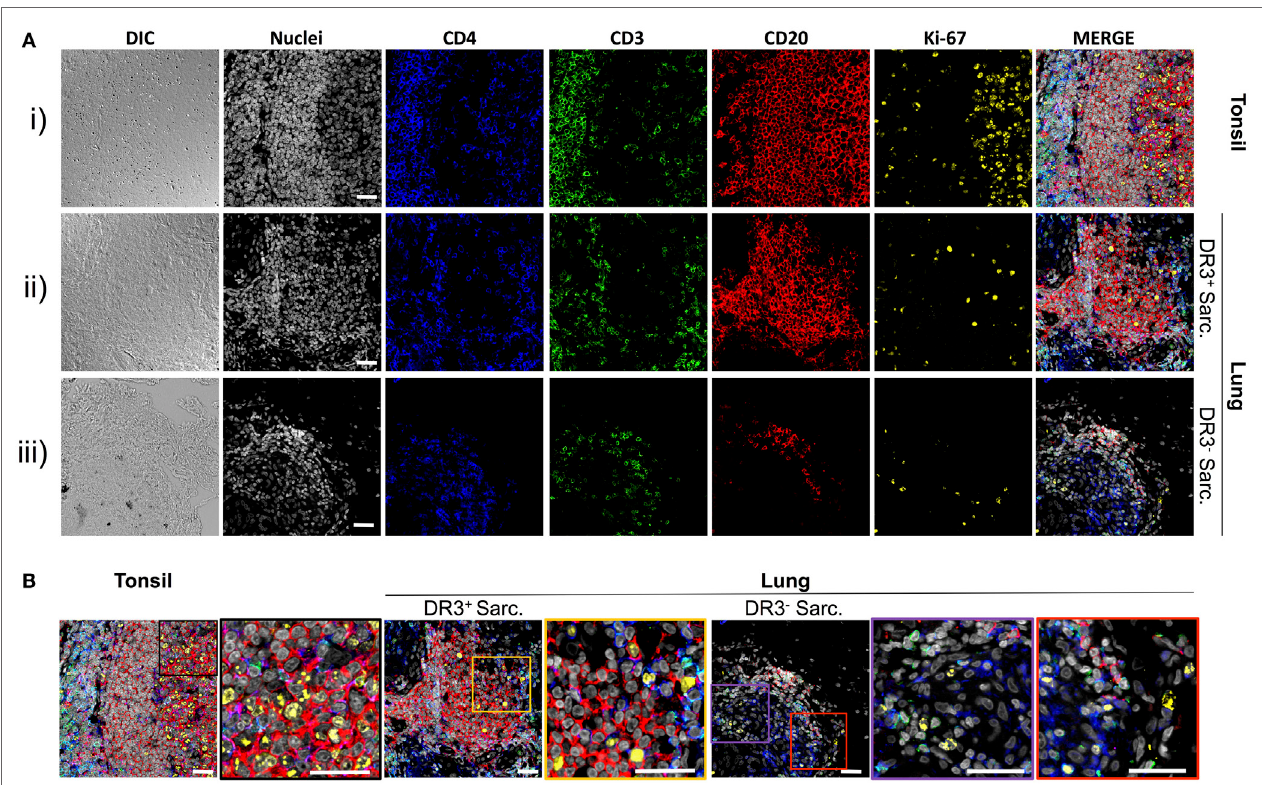
FigUre 3 | T-cells, B-cells, and proliferating cells in tonsil, HLA-DRB1*03 + , and HLA-DRB1*03 − sarcoid lung. As for Figure 2 , tonsil was used as a positive control for multi-color confocal microscopy, but using CD4 + T-cell markers CD3 and CD4, the B-cell marker CD20, and the proliferation marker ki-67 [ (a) i]. Analogous stains were performed on HLA-DRB1*03 + LS [ (a) ii] and HLA-DRB1*03 − non-LS lung [ (a) iii] tissue biopsies. Magnified areas of merged channels labeled showing typical proliferating cell populations are detailed in (B) . Images were acquired with an oil immersion 40 × objective. Scale bar length = 25 µm. Colored boxes correspond to highlighted areas of interest magnified from adjacent